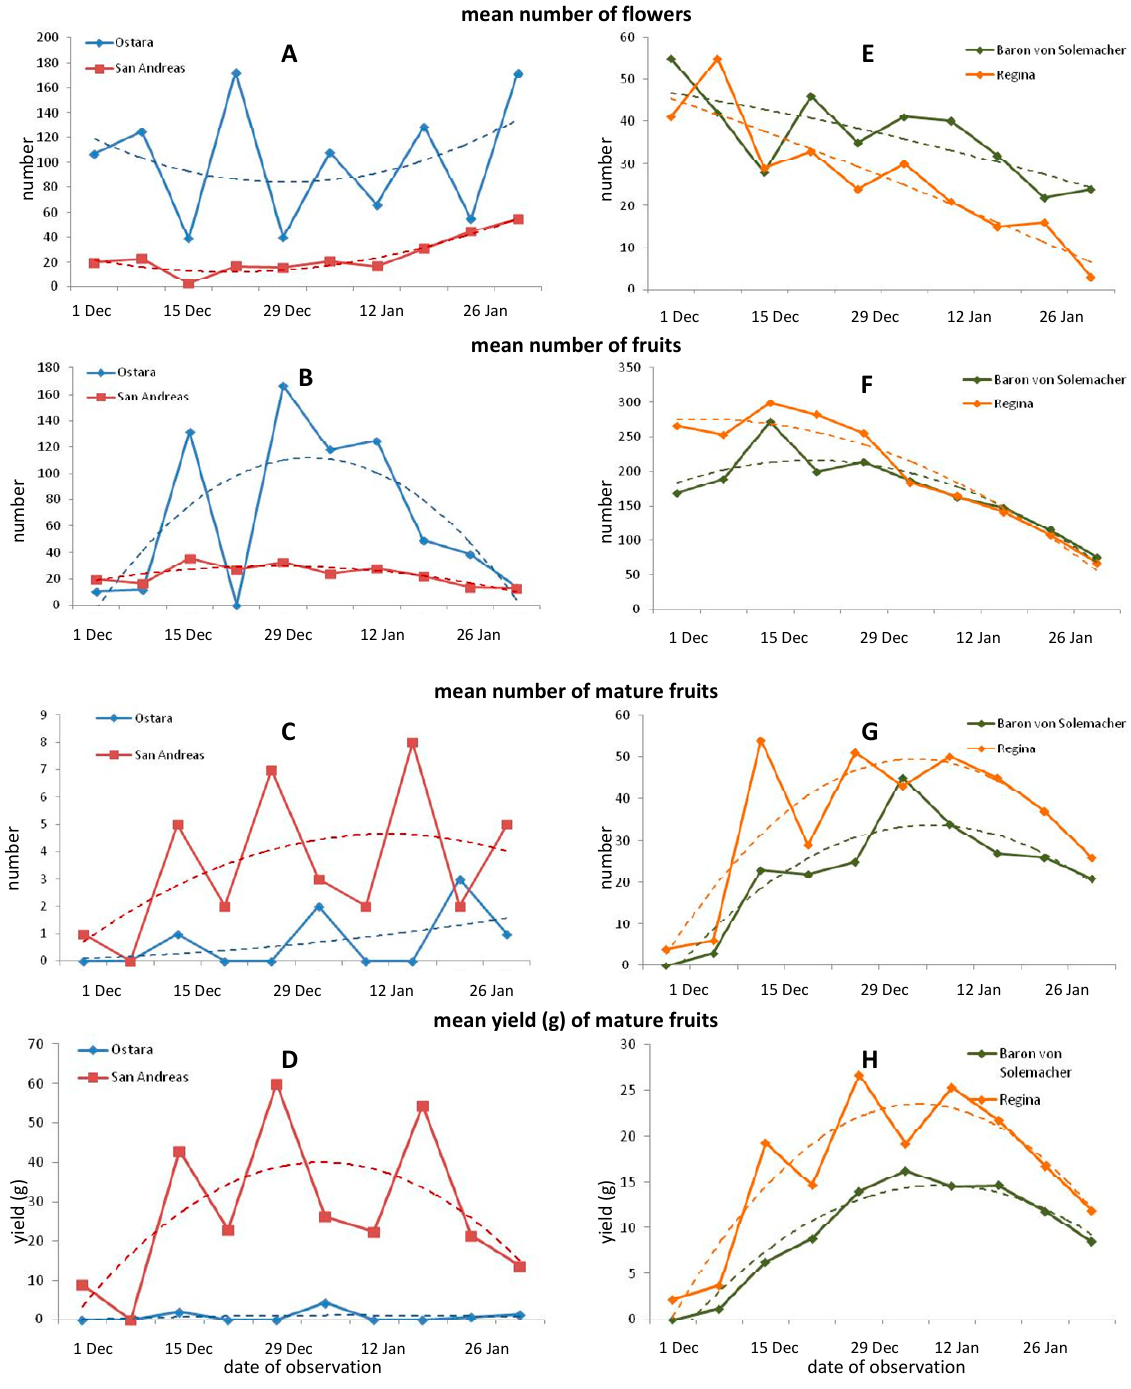
Figure 2. Flowering and yield data from weekly measurements in strawberry ( A – D ) and wild strawberry ( E – H ). ( A ) and ( E )—mean number of flowers per plant; ( B , F )—mean number of fruits per plant; ( C , G )—mean number of mature fruits per plant; ( D , H )—mean fresh weight (g) of the mature fruit. Dotted lines represent polynomial trends for particular parameters and cultivars.